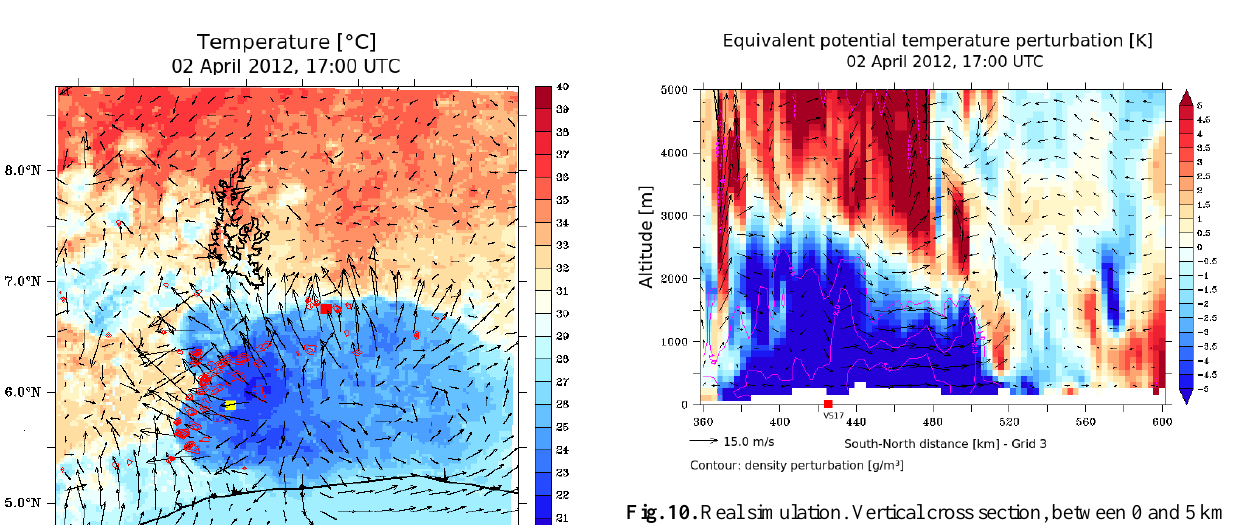
Fig. 10. Real simulation. Vertical cross section, between 0 and 5km altitude, of equivalent potential temperature perturbation [K] on 2 April 2012 at 17:00 (UTC), calculated over a south–north plane coincident with the position of station VS17 (indicated by a red square symbol). Perturbation is defined as in Fig. 3. The x axes rep- resent the distance from the southern bound of the inner model grid. White spaces at ground level indicate surface elevation. Wind vec- tors and contours (with solid and dotted line for positive and neg- ative values, respectively) of percentage density perturbation (i.e., with regard to domain average) are overplotted. The length of an arrow is proportional to wind intensity, as specified in the figure’s